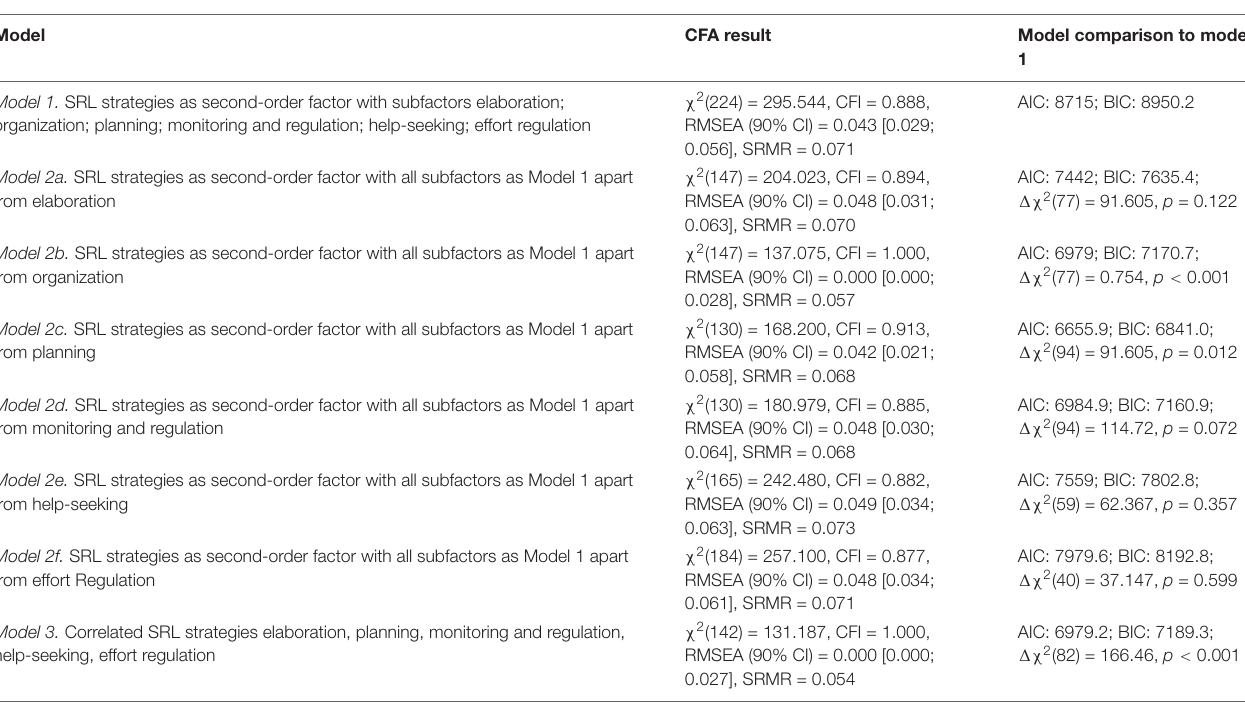
TABLE 3 | Results of confirmatory factor analysis and model comparisons of SRL strategies.